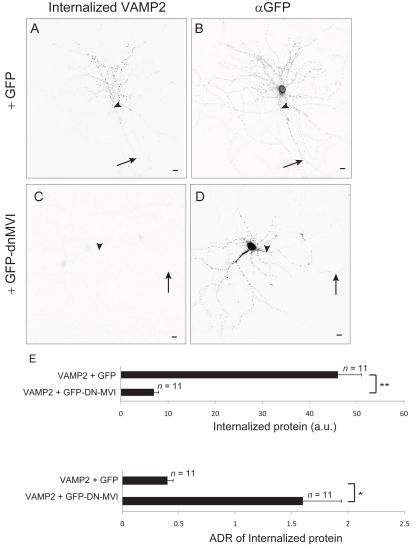
Interaction with Myosin VI is necessary for dendrite-specific endocytosis.Internalized exogenous VAMP2 (A) is localized primarily to dendrites in a cortical neuron coexpressing GFP (B). In contrast, much less VAMP2 (C) was internalized in cells coexpressing GFP-dnMVI (D). (E) Significantly more VAMP2 was internalized when it was coexpressed with GFP than when it was coexpressed with GFP-dnMVI. Furthermore, ADRs show that VAMP2 was internalized preferentially from the surface of the dendrites when coexpressed with GFP, but was internalized roughly equally from surfaces of the dendrites and from the axon when coexpressed with GFP-dnMVI. *, p<0.003; **, p<0.0001; Wilcoxon-Mann-Whitney test. Arrows point to the axon; arrowheads point to the axon initial segment. Scale bars are 10 µm.